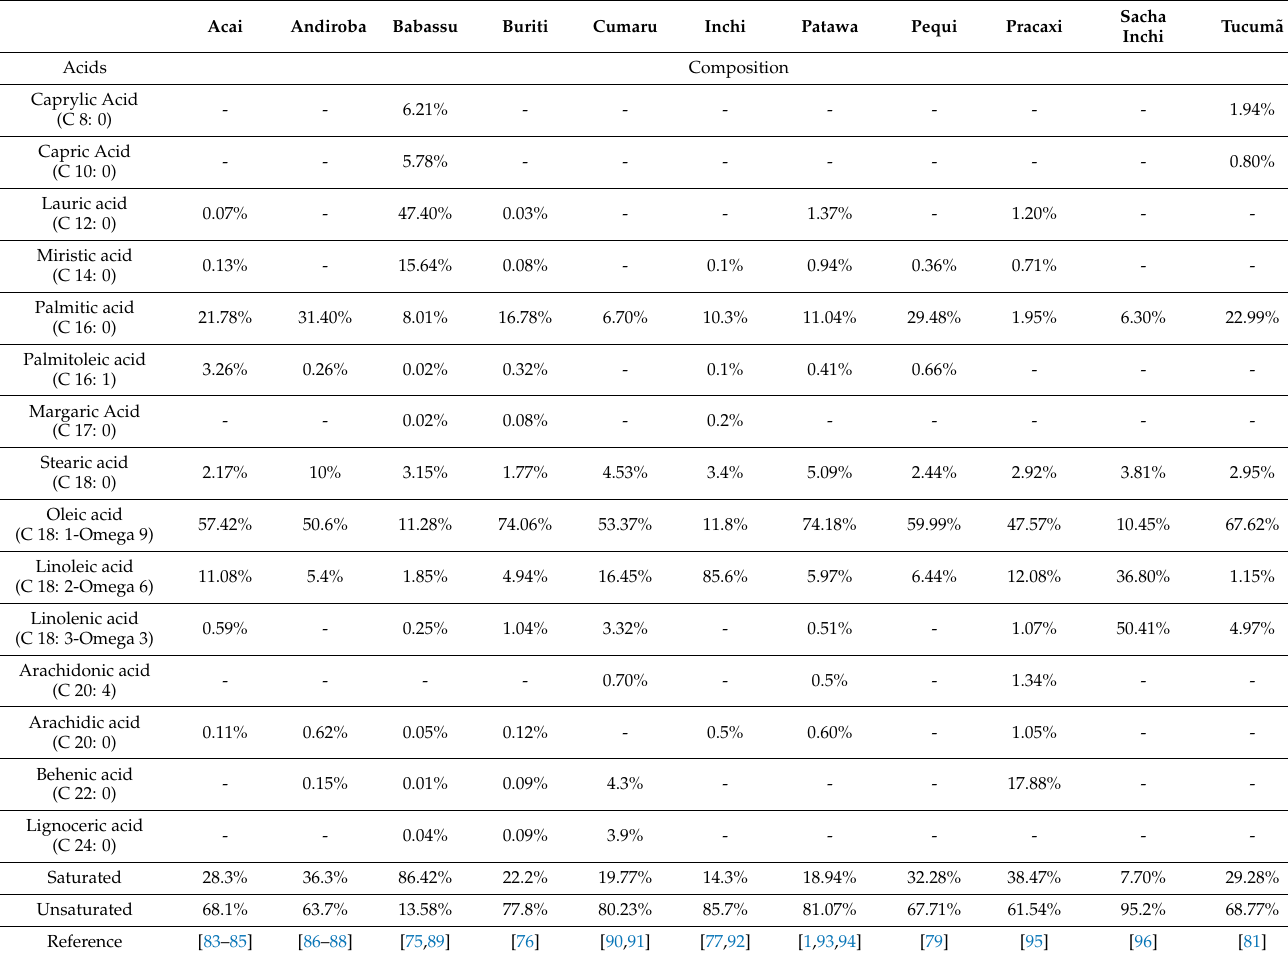
Table 2. Fatty acid profile of different Amazonian vegetable oils by alphabetical order; (-): not reported. Acai Andiroba Babassu Buriti Cumaru Inchi Patawa Pequi Pracaxi Sacha Inchi Tucum ã Composition